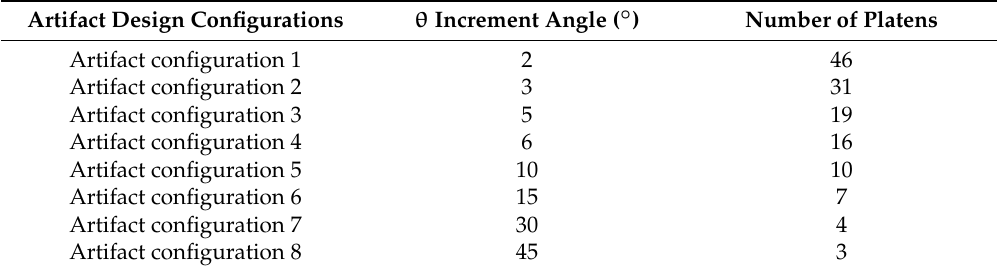
Table 1. The design configurations of the surface inspection artifact.